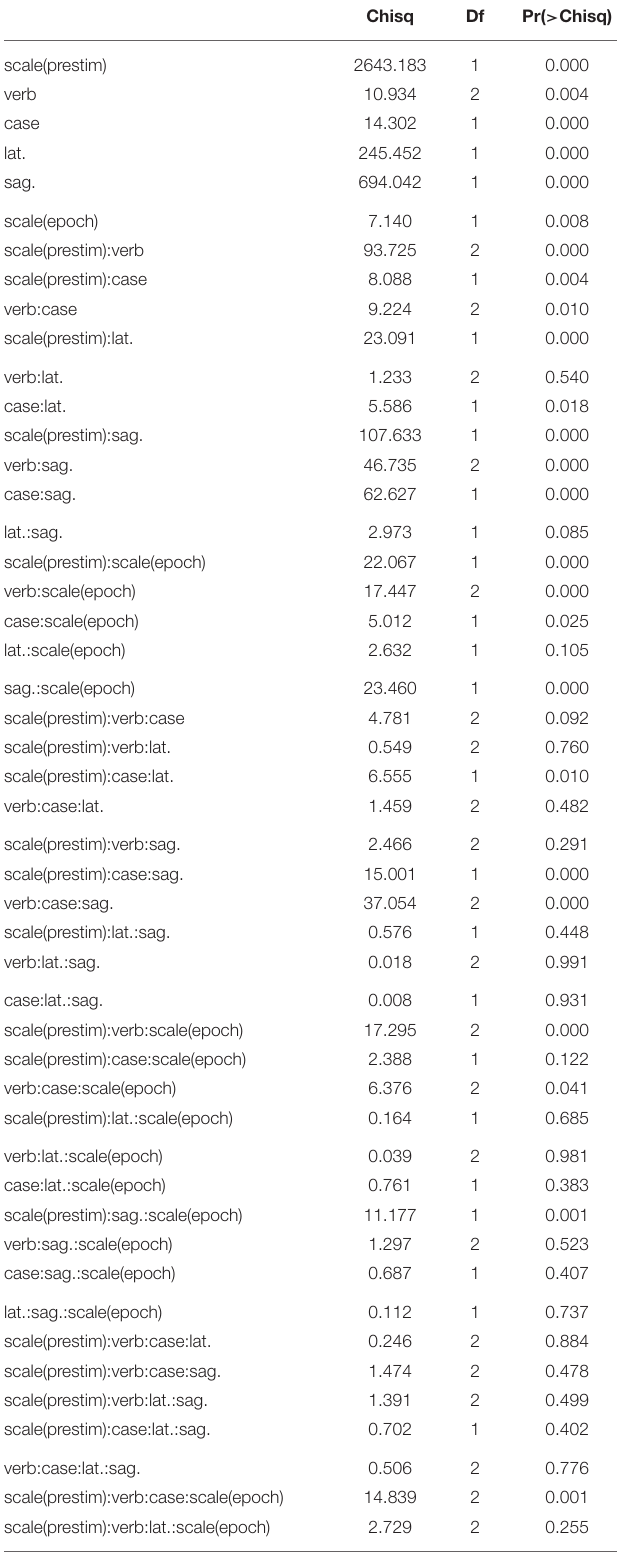
TABLE 2 | Summary of effects in N400 time window (Type II Wald